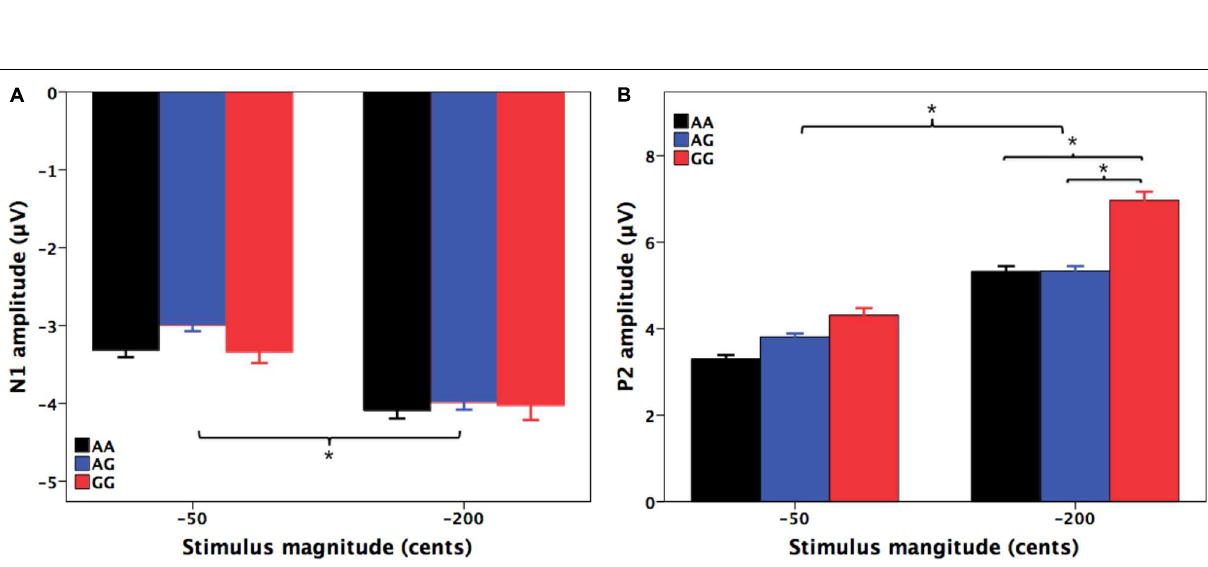
Frontiers in Neuroscience |